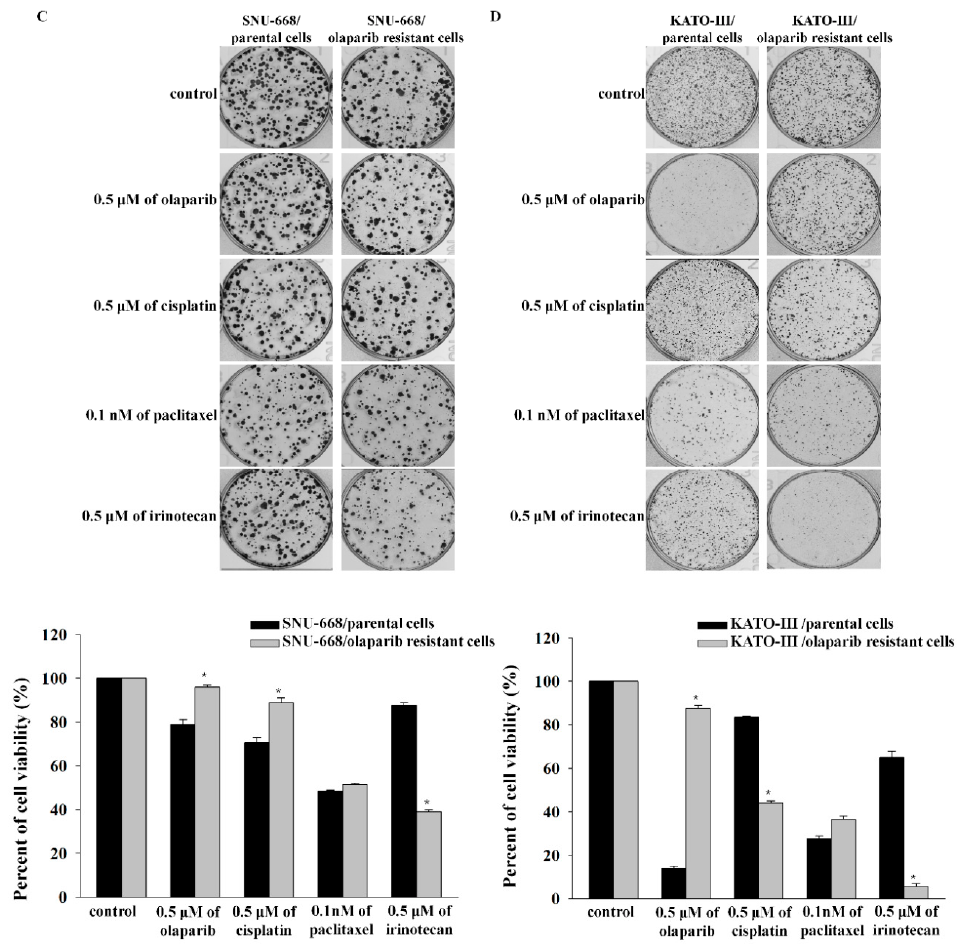
Figure 1. The sensitivity of chemotherapeutic agents was altered in olaparib-resistant cells. Cell viability was calculated through counting cell colonies by using GELCOUNT in SNU-484 ( A ), SNU-601 ( B ), SNU-668 ( C ), and KATO-III ( D ) cells. * indicates p < 0.001. 2.2. Changes of Proteins Related to the DNA-Damage Response in Olaparib-Resistant Cell Lines To evaluate the mechanisms underlying the altered sensitivity toward cisplatin, changes of the DNA-damage response proteins were evaluated. p-ATR was induced in all olaparib-resistant cell lines (Figure 2). p-ATM was slightly upregulated in olaparib-resistant SNU-484 and olaparib- resistant SNU-668. p-Chk1 and p-Chk2 were elevated in olaparib-resistant cell lines compared with the parental cells. Furthermore, ERCC1 was also upregulated in olaparib-resistant SNU-484, SNU- 601, and SNU-668 cells, which were resistant to cisplatin. This ERCC1 induction was not detected in olaparib-resistant KATO-III cells, which were not resistant to cisplatin.